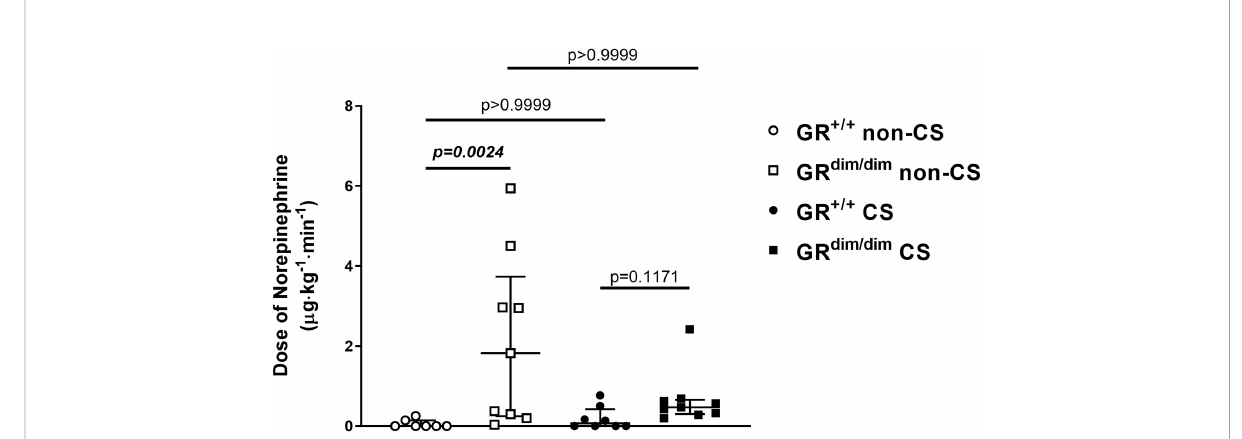
FIGURE 1 Doses of norepinephrine(NE) in mechanically ventilated GR dim/dim and GR +/+ mice with or without cigarette-smoke (CS) exposure and after 1 h of hemorrhagic shock (HS, mean arterial pressure (MAP) 35 mmHg) and subsequent resuscitation (colloids, NE) for 4 h. NE was titrated intravenously during resuscitation to keep MAP ≥ 55mmHg. GR +/+ mice non-CS: n = 7, GR dim/dim mice non-CS: n = 9, GR +/+ mice CS: n=8, GR dim/dim mice CS: n = 9. Data is presented as median (25 th and 75 th percentile and